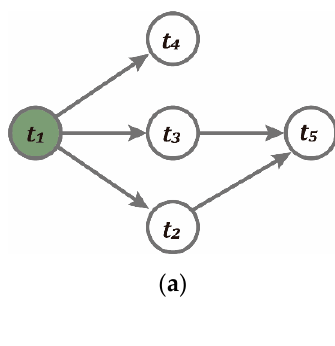
Table 1. Comparison of Related